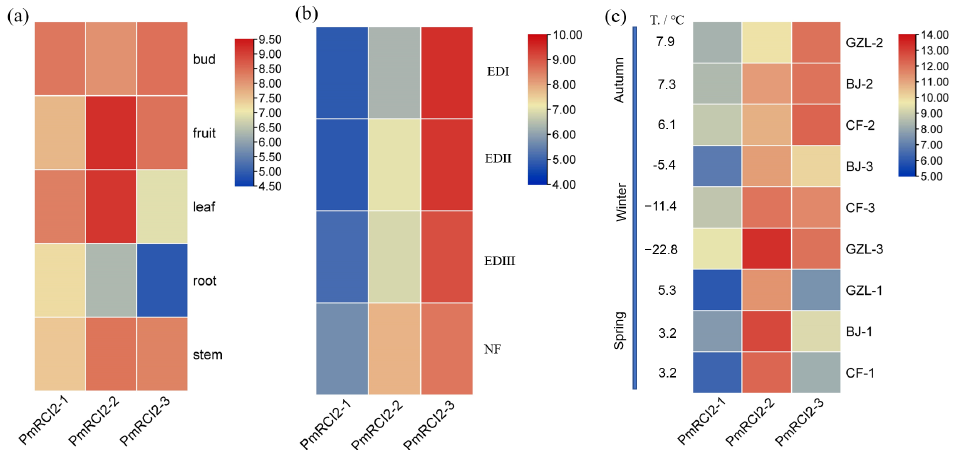
Figure 5. The expression pattern of PmRCI2 s. ( a ) The expression level of PmRCI2 s in different tissues of P. mume . ( b ) An examination of the expression levels of PmRCI2 s in flowers of P. mume “Zao Lve” during three stages of endodormancy at low temperatures. ( c ) Three regional test sites (Beijing, BJ; Chifeng, CF; Gongzhuling, GZL) were used to collect data on the expression accumulation of P. mume “ Songchun ” stems during three different periods (autumn, winter, and spring). In the same season, the average temperature of different locations is ranked from high to low. For further understanding the role of PmRCI2 genes in response to cold stress, the expression level of PmRCI2 genes under different treatments was detected by qRT-PCR (Figure 6). Under the condition of cold treatment at 4 °C, the expression level of PmRCI2- 3 was significantly higher than that of without cold treatment. The expression level of PmRCI2-3 increased gradually with the prolonged cold treatment time and reached the maximum value at 9 d. The increase in the expression of PmRCI2-3 was also significantly higher than the other two genes. Under different temperature treatments, the expression levels of PmRCI2-1 and PmRCI2-2 fluctuated to a certain extent but did not show a signif- icant upward or downward trend. However, the expression level of PmRCI2-3 gradually increased with the severity of cold stress and reached a peak at − 8 °C. These results demonstrate that PmRCI2-3 is significantly induced by cold stress and plays an important role in resisting constant low-temperature conditions.